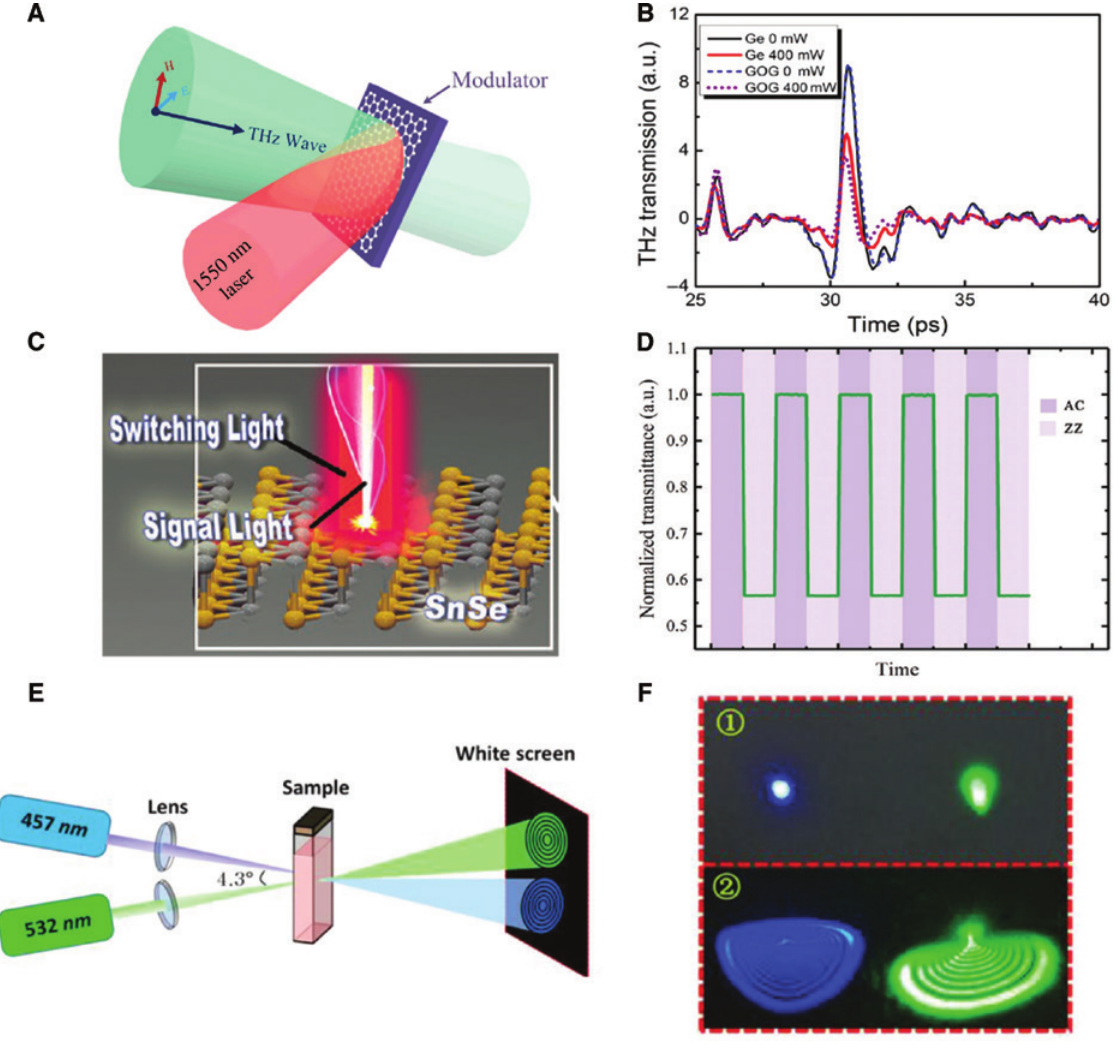
Figure 7: 2D materials-based all-optical modulation in free space. (A) Schematic configuration of all-optical terahertz modulators. (B) Temporal profiles of the transmittance of graphene-on-germanium (GOG) compared with the pure Ge substrate with and without photodoping [88]. (C) Schematic diagram of a novel all-optical modulator based on anisotropic layered materials SnSe. (D) Transmittance of the signal light with switching light of two orthogonal polarizations [145]. (E) Schematic of a novel spatial all-optical modulator based on the spatial cross-phase modulation. (F) Typical experimental results of the all- optical modulators; spatial profiles of the signal (blue) and switching laser (green) beam before (upper figure) and after (lower figure) the cross-phase interaction [146]. (A and B) Reproduced with permission [88]. Copyright 2014, Nature Publication Group. (C and D) Reproduced with permission [145]. Copyright 2019, WILEY-VCH. (E and F) Reproduced with permission [146]. Copyright 2018,